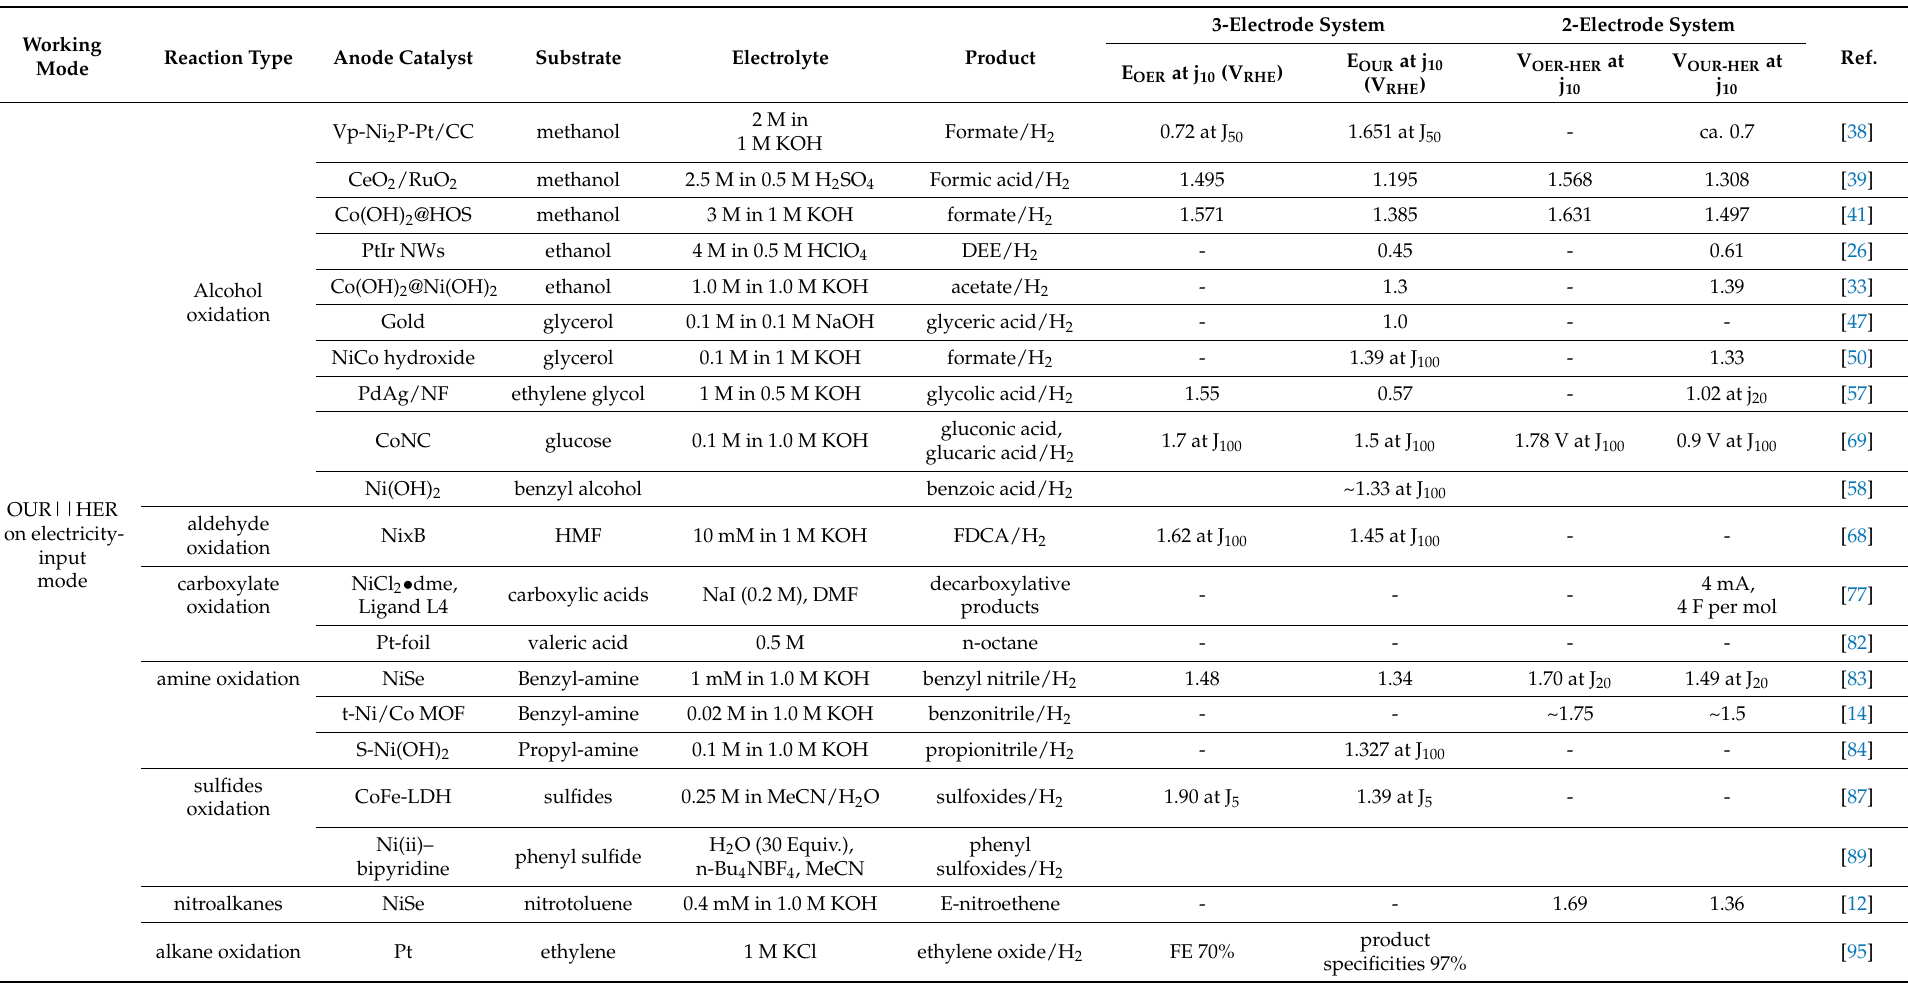
Table 1. Electrocatalytic performance of recently reported representative OUR electrocatalysts and the OUR||HER-based electricity-input